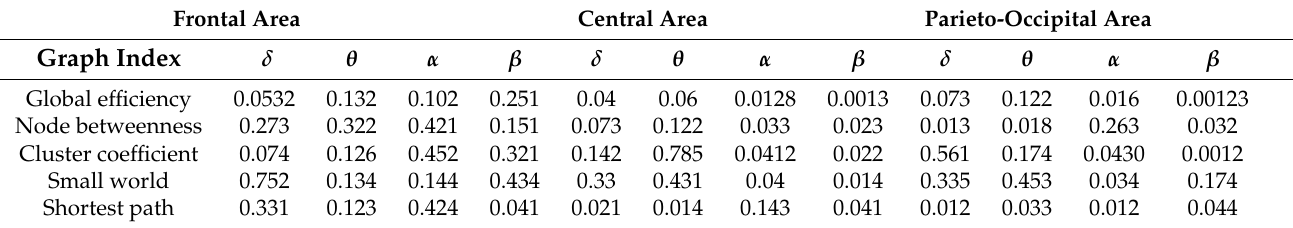
Table 1. The table report results from a statistical analysis across cluster of EEG sensors (see EEG layout parcelization in Section 5.1) in all of the frequencies band under analysis. We evaluated Global efficiency, Node betweenness, Cluster coefficient, Small world, and Shortest path characteristic. We performed a post-hoc analysis for multi-comparison. The p -value ( p < 0.05) corresponds to significant difference in network index values for the testing conditions. See Section 3.7 for further